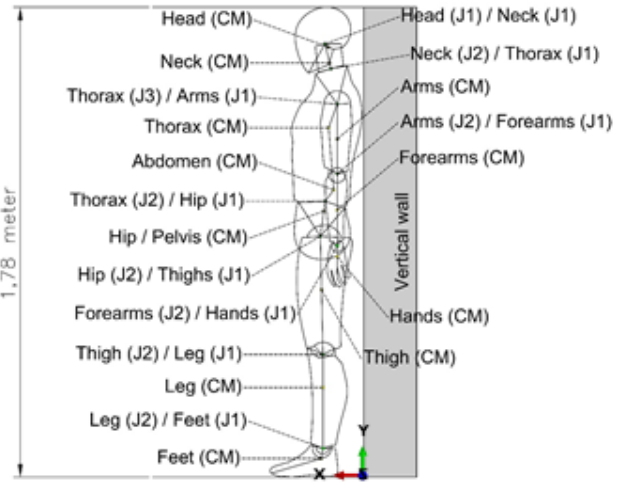
Figure 5. Model adopted for the human